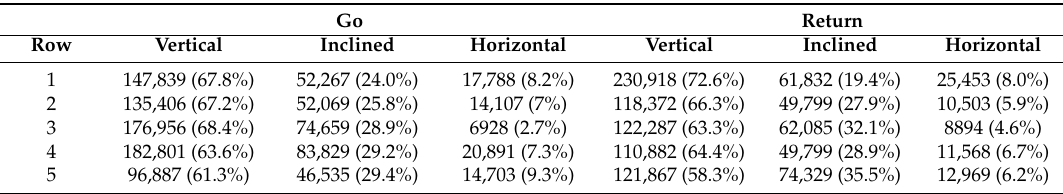
Table 4. Raw point cloud data recorded during the experiments.